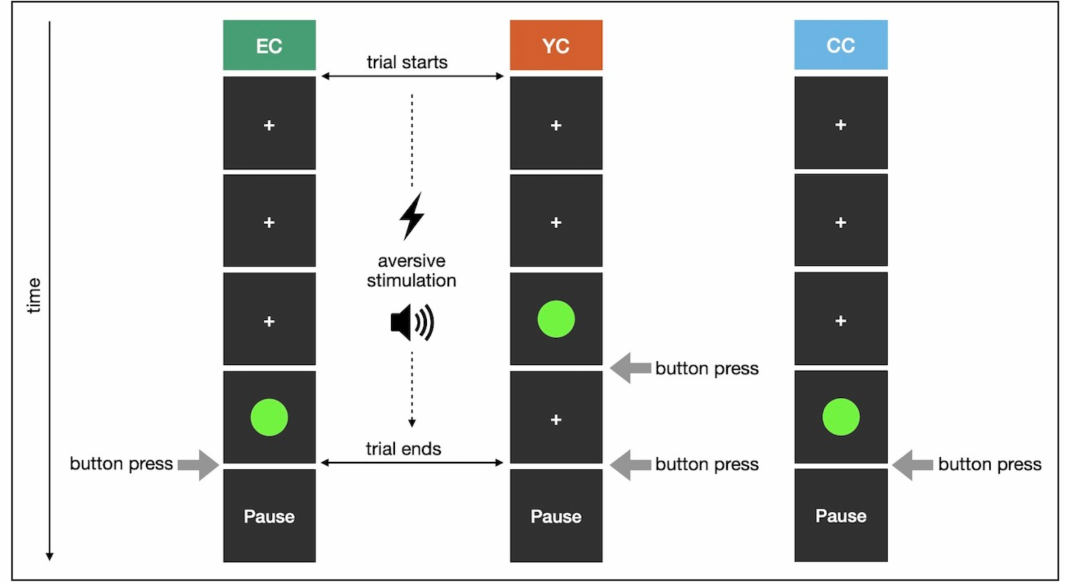
Figure 4. Stress induction in study 1 (one trial; EC participant successfully terminated aversive